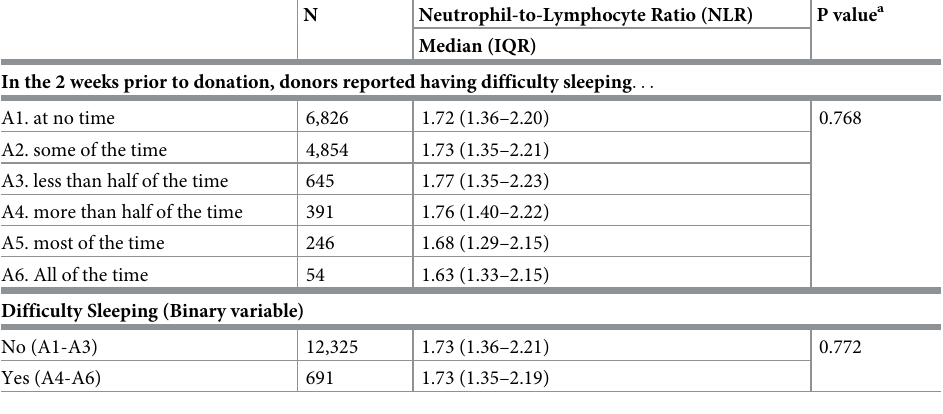
Table 2. Median NLR in blood donors reporting difficulty sleeping in the DBDS NLR-RLS dataset, excluding 39 who did not answer the question (N = 13,016). N Neutrophil-to-Lymphocyte Ratio (NLR) P value a Median (IQR) In the 2 weeks prior to donation, donors reported having difficulty sleeping ...